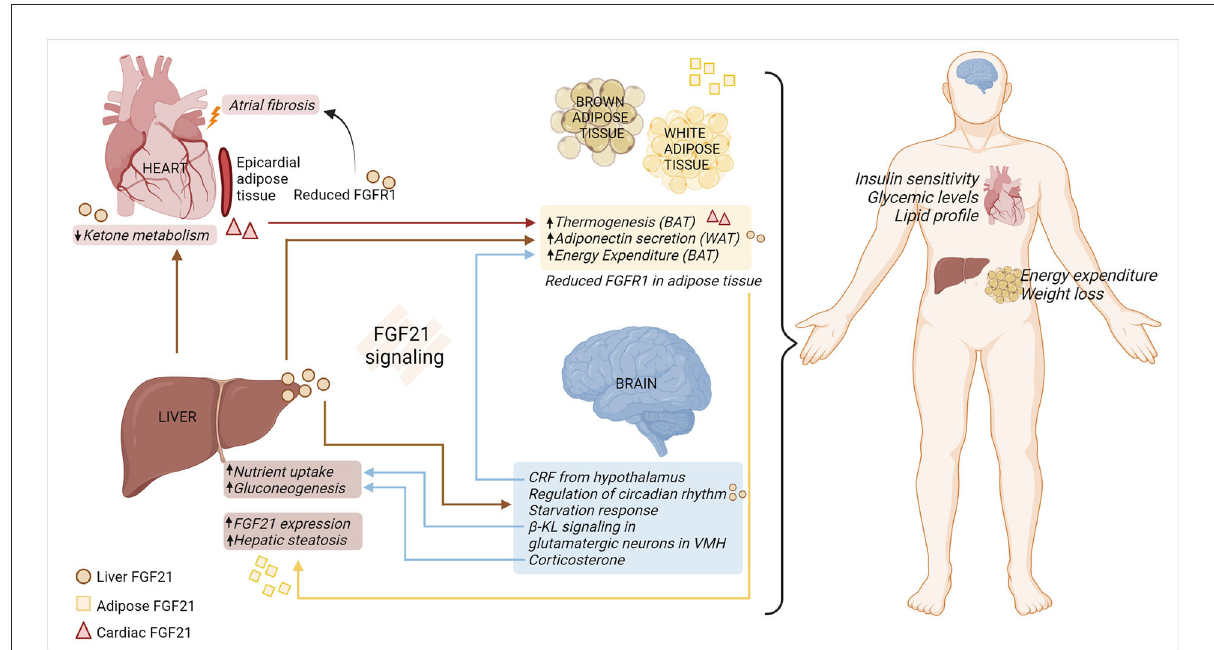
FIGURE1 FGF21-FGFR1/ β -KL regulation of multi-organ crosstalk under metabolic stress. FGF21-FGFR1/ β -KL signaling is vital in regulating systemic and organ responses under pathophysiological metabolic stress. Hepatic sourced FGF21 (circle) reduces ketone metabolism in the cardiomyocytes, induces secretion of adiponectin from WAT, and modulates systemic metabolism. Moreover, hepatic sourced FGF21 passes through the blood-brain barrier and is involved in regulation of circadian rhythm and appetite response. In a feedback loop, β -KL signaling in the VMH-specific glutamatergic neurons contributes to modulating hepatic nutrient uptake. The release of CRF and corticosterone from the brain is responsible for regulating energy expenditure in the adipose tissue and liver gluconeogenesis, respectively. Cardiac sourced FGF21 (triangle) promotes thermogenesis in the adipose tissue, thus improving overall metabolic health. Under the adipo-hepatic communication, reduced expression of adipose FGFR1 aggravates hepatic steatosis and adipose FGF21 (square) increases the expression of hepatic FGF21. Hence, multi-organ crosstalk mediated by FGF21-FGFR1/ β -KL signaling alleviates metabolic distress by improving insulin sensitivity, glucose, and lipid levels in the body, along with increased energy expenditure in the adipose tissue and weight loss. BAT, brown adipose tissue; β -KL, beta-klotho; CRF, corticotropin releasing factor; FGF21, fibroblast growth factor 21; FGFR1, fibroblast growth factor receptor 1; VMH, ventromedial hypothalamus; WAT, white adipose tissue (created with